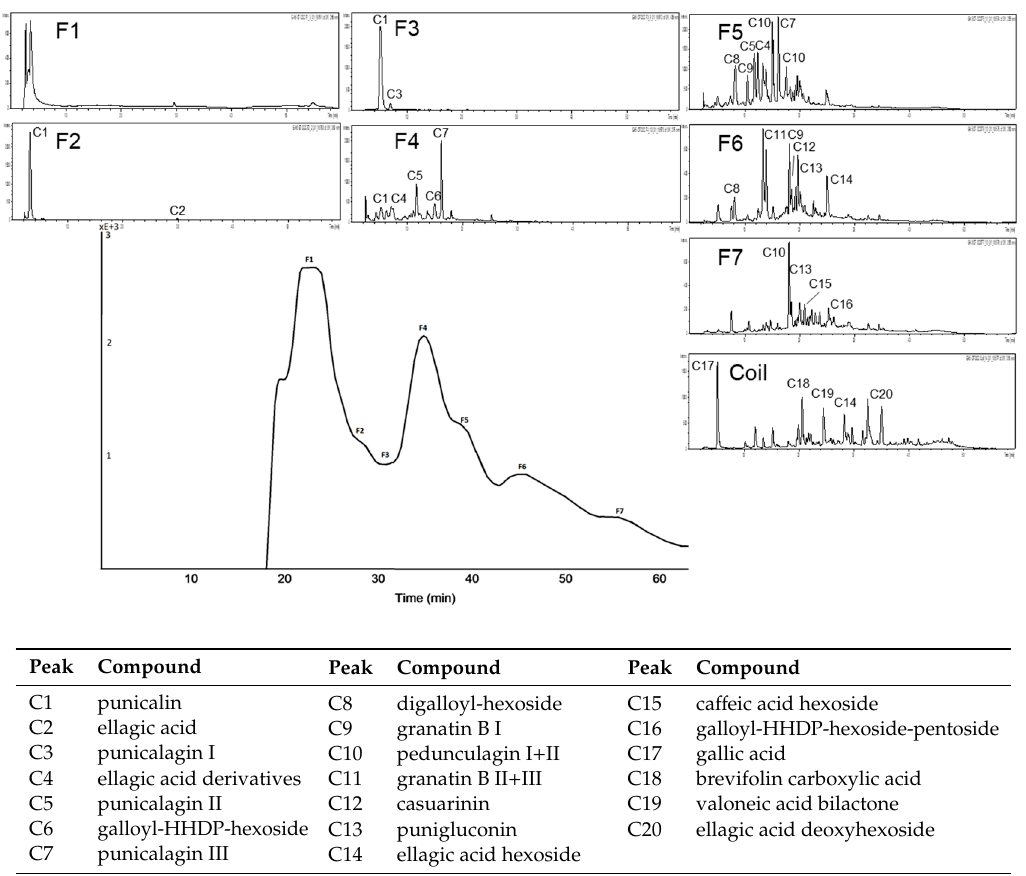
Figure 11. HPCCC chromatogram of CF of pomegranate NFC at a wavelength of λ 320 nm of P-CF and HPLC-ESI-MS / MS chromatograms of the composition of each fraction. Abbreviation: HHDP, hexahydroxydiphenyl.